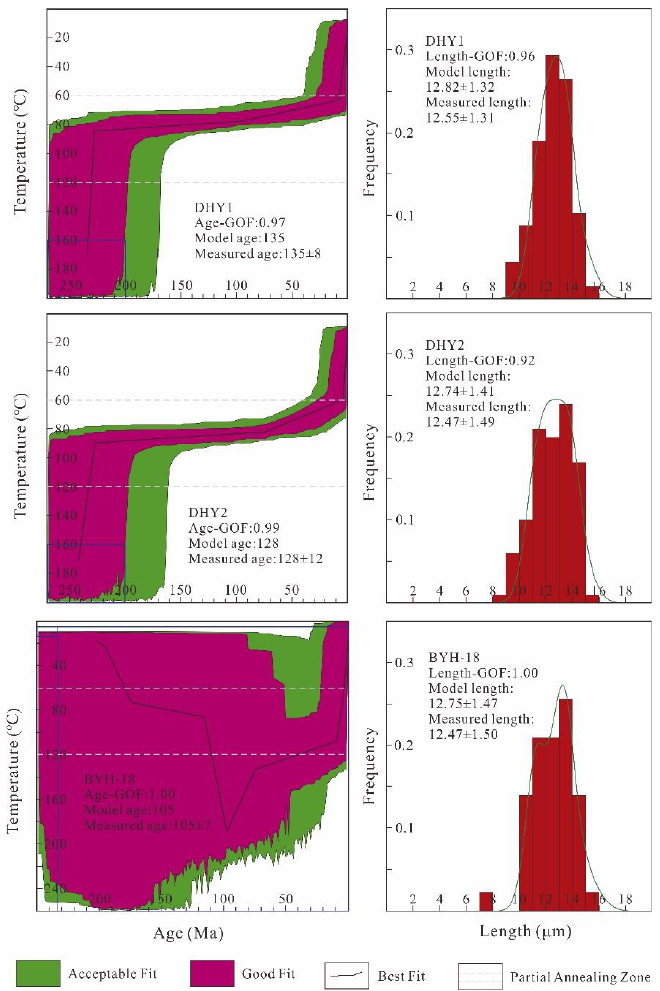
Figure 6. Modeled inverse time – temperature (t-T) paths and length distribution for DHY1, DHY2, and BYH18. GOF is the goodness of fit between the data measured and those predicted by the model. Cooling paths of individual samples were calculated with HeFTy [34,47], based on the annealing model of [41]; blue box is the constraint box.